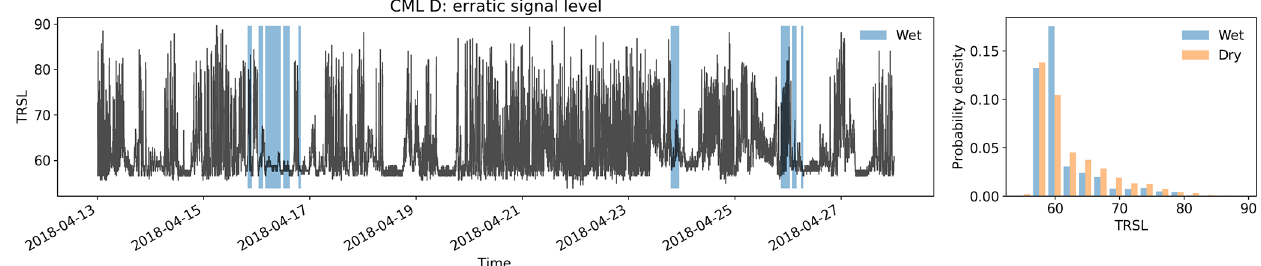
Figure A2. Time series of a CML that is considered erratic and is removed by the simple filter for erratic CML data introduced in Graf et al. (2020). There are no time periods where a reasonable rainfall estimation would be